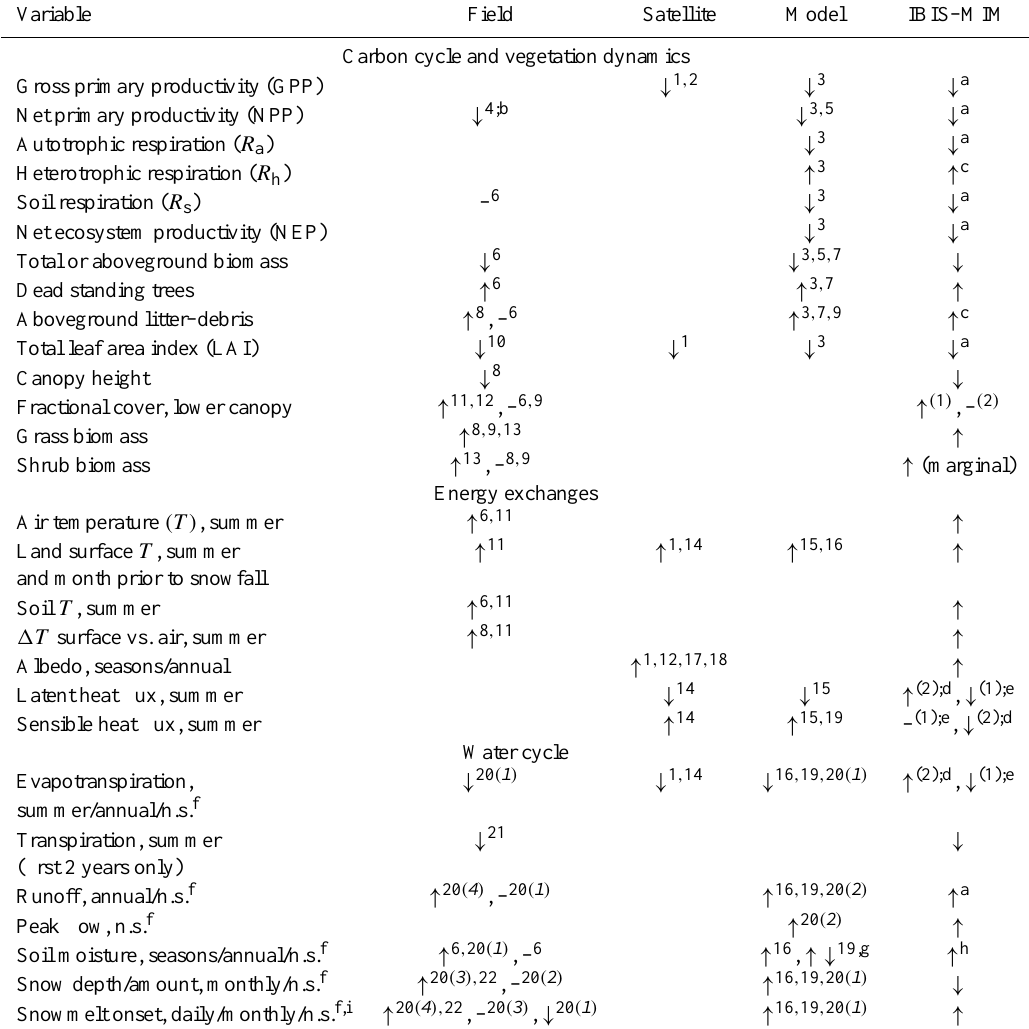
Table 4. Comparison of IBIS–MIM results for a simulated MPB outbreak with field-, satellite-, and model-based studies (increase: ↑ ; no change: –; decrease: ↓ ). Under the “field”, “satellite”, and “model” columns, the numbers refer to the studies listed below. Under the “IBIS– MIM” column, the values in parentheses give the number of grid cells sharing the same qualitative results (only provided when the three grid cells